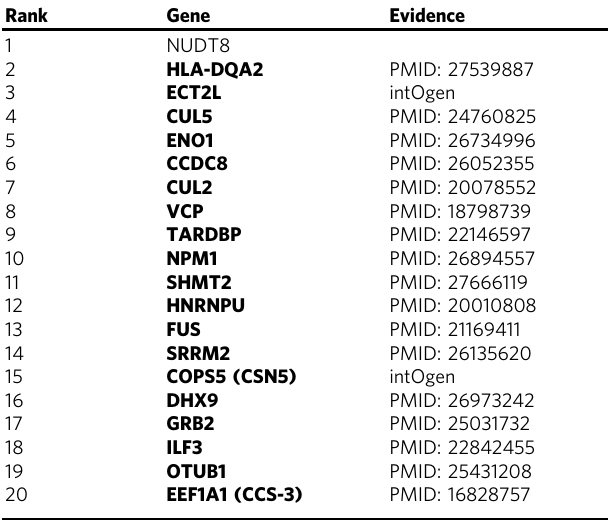
The table ranks genes expressed across all twenty cancers we considered according to their rewiring across the twenty integrated cancer iCells (least rewired fi rst). Genes in bold have literature support of their role in cancer, or are known cancer drivers according to